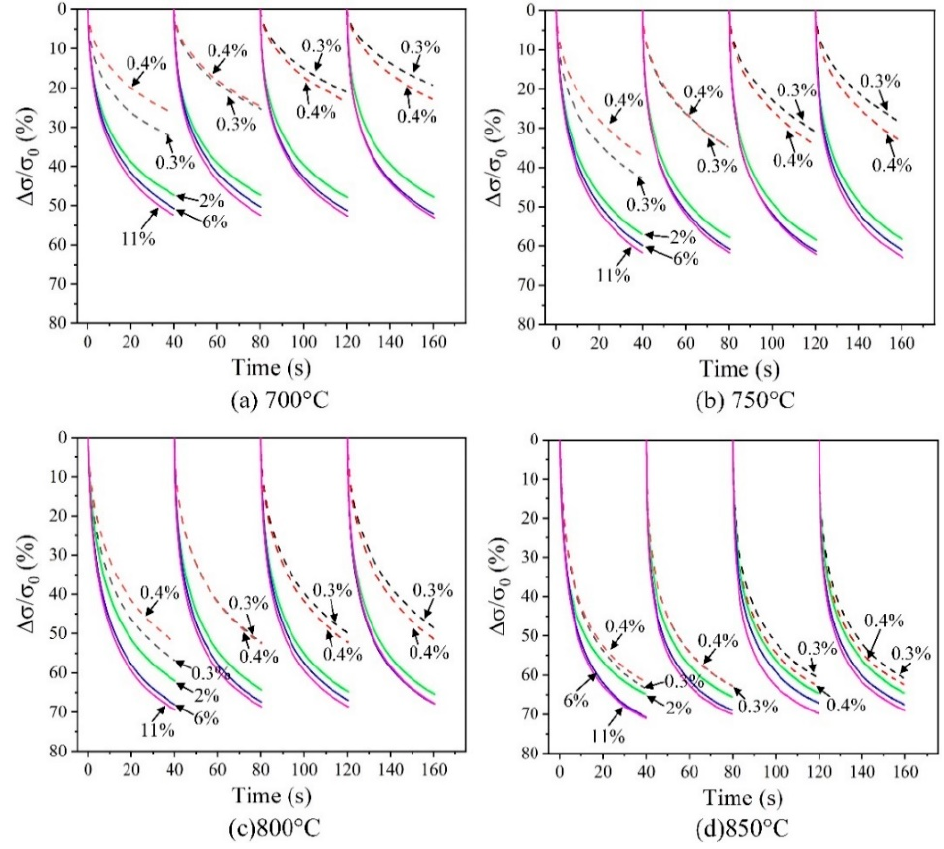
Figure 5. Normalized repeated stress relaxation behavior of Ti-6Al-4V alloy at indicated temperatures, ( a ) 700 °C, ( b ) 750 °C, ( c ) 800 °C and ( d ) 850 °C.